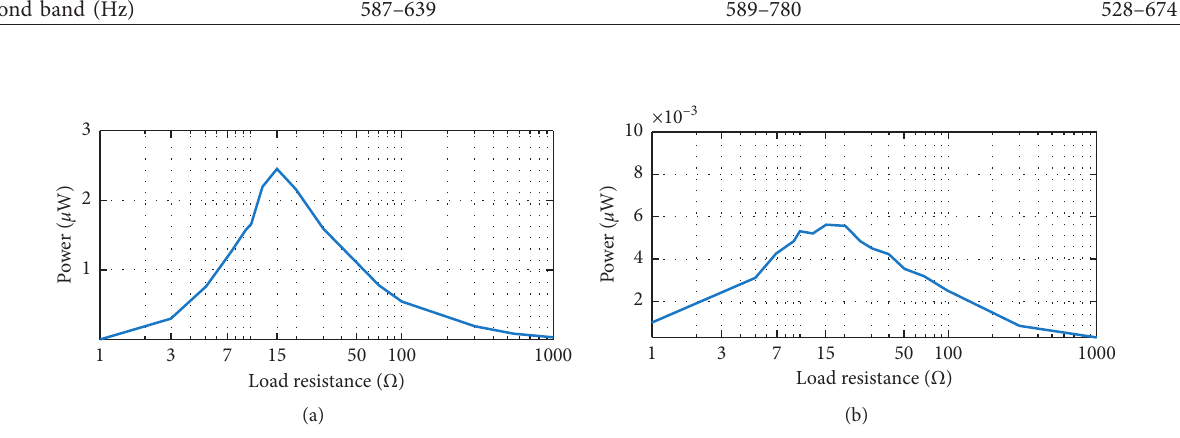
Figure 10: Measured electric power from a single cantilever within a unit cell at (a) 223 Hz and (b) 615Hz and 0.5g m.s − 2